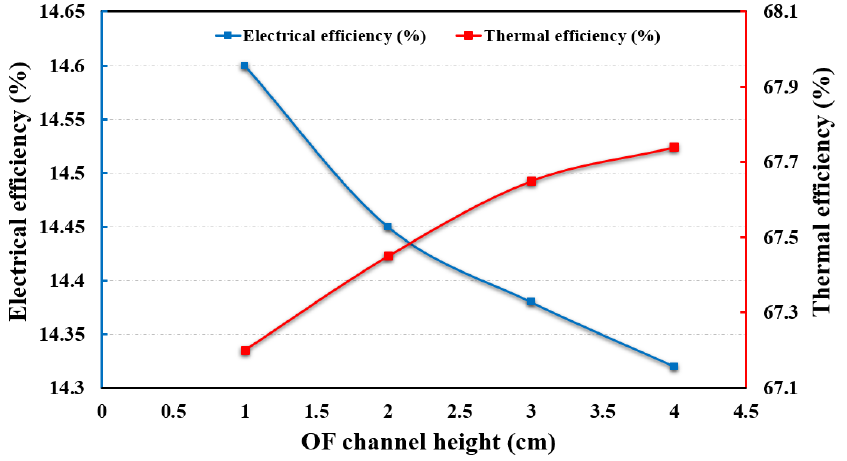
Figure 11. Influence of OF channel height on thermal and electrical efficiency.